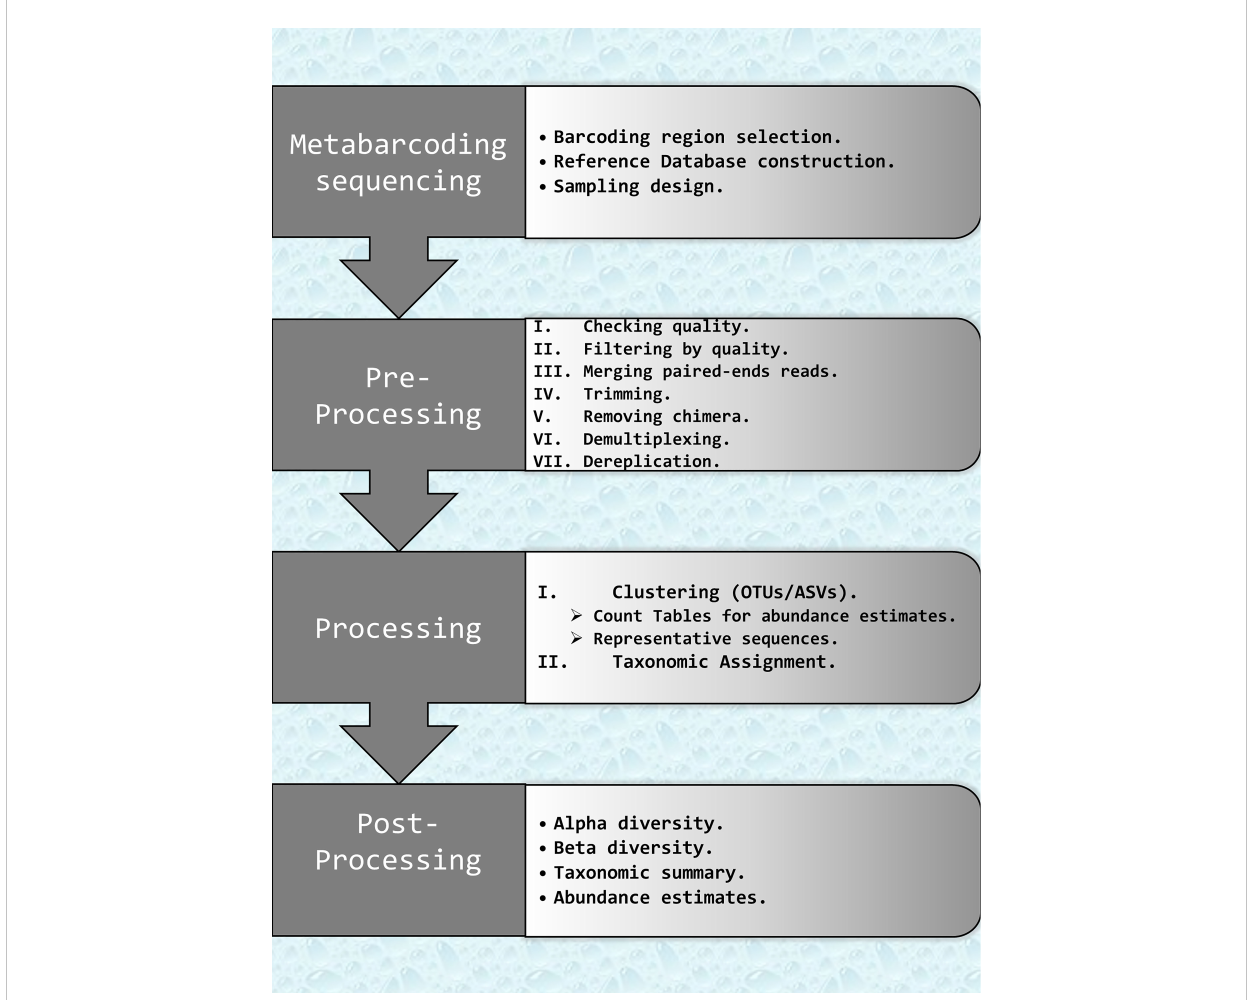
FIGURE 1 Flowchart describing the key bioinformatics steps required to analyze eDNA metabarcoding data. Steps are split in three parts: Pre-processing: fi ltering and correction raw data. Processing: clustering and taxonomic assignments; and Post-processing: statistical analysis and biodiversity index. OTUs, Organizational Taxonomic Units; ASVs, Amplicon Sequence